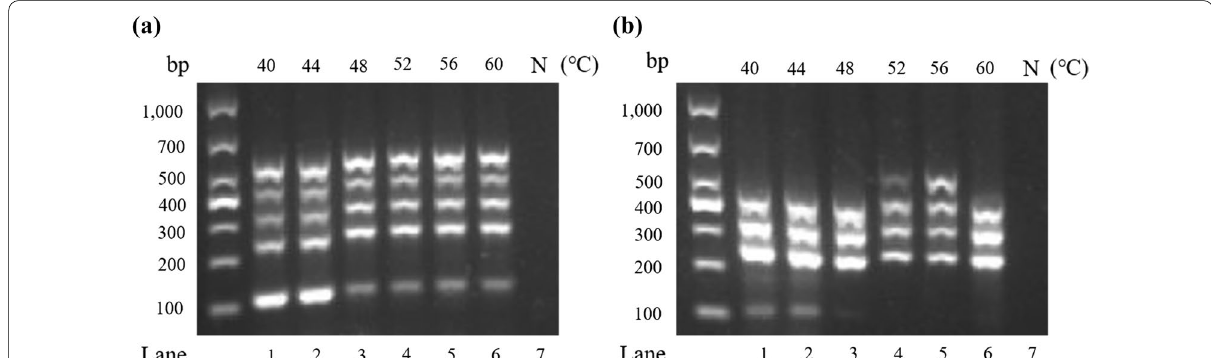
Fig. 3 Annealing temperature optimization comparison between DPO primers and conventional primers. Lanes 1–6 represent 40 °C, 44 °C, 48 °C, 52 °C, 56 °C, 60 °C, for a gradient with 6 temperatures; Lane 7 represents negative template (N). a DPO primer annealing temperature optimization test; b Normal annealing temperature optimization test for